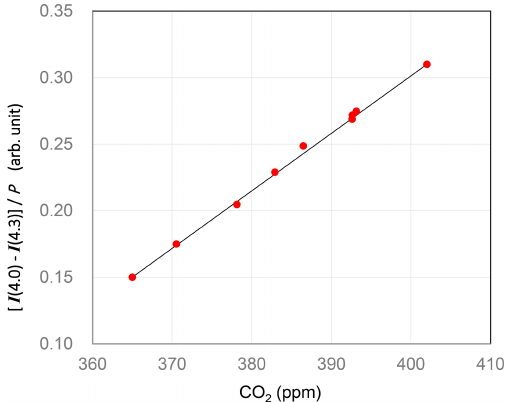
Figure 4. [ I ( 4 . 0 ) − I ( 4 . 3 ) ] /P values versus CO 2 mole fraction, where I( 4 . 0 ) and I( 4 . 3 ) are the signal intensities at the 4.0µm wavelength for background measurements and the 4.3µm wave- length for CO 2 absorption measurements, obtained by the NDIR CO 2 sensor, and P is the ambient atmospheric pressure. CO 2 mole fractions were measured with a standard NDIR instrument (LICOR, LI-840A) connected to the balloon sensor in series. The pressure while carrying out the measurements was constant at